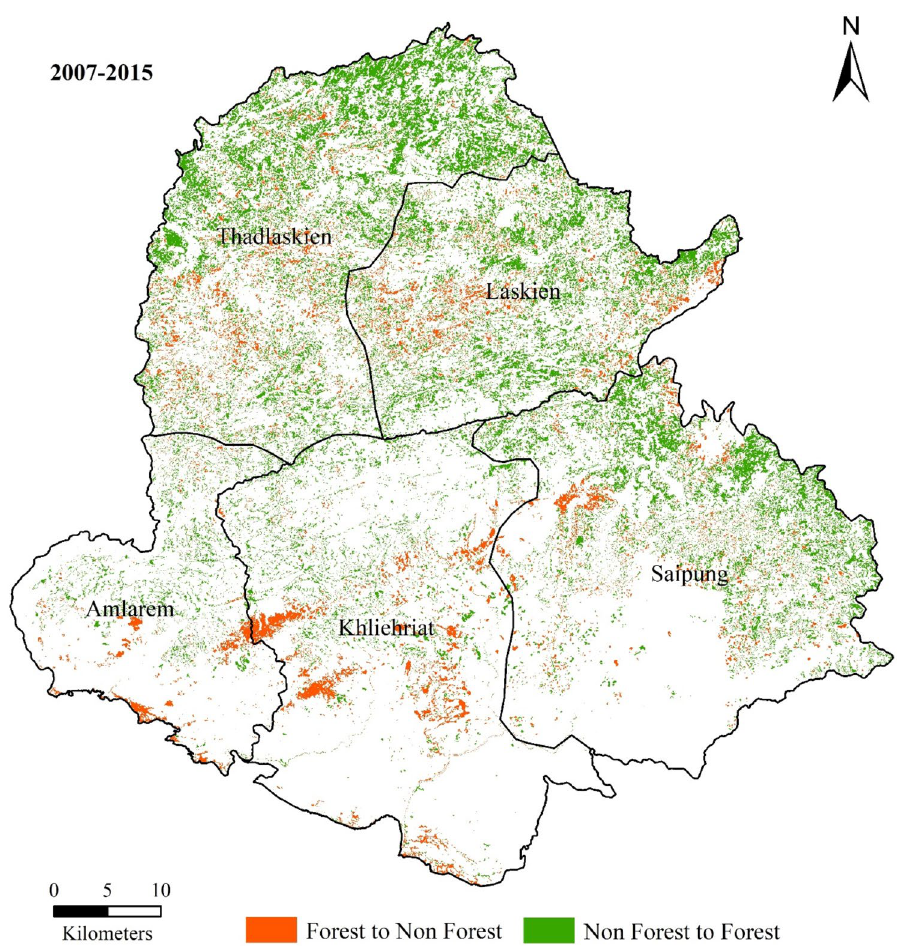
Fig. 6 Change in forest class map for the year 2007 to